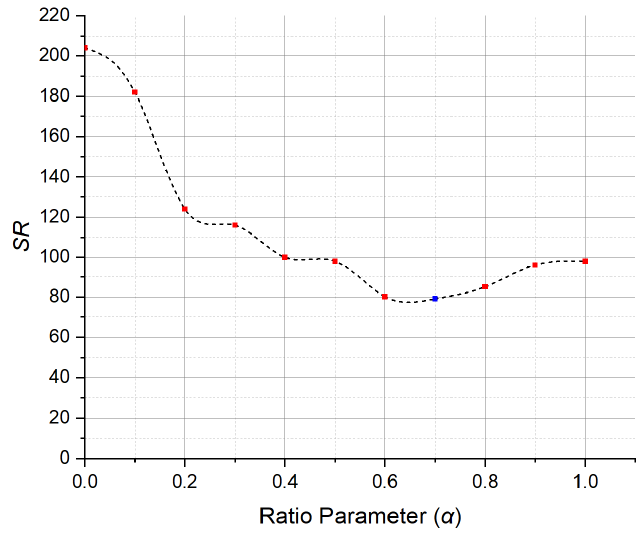
Figure 7. Minimum values of SR when α changes.